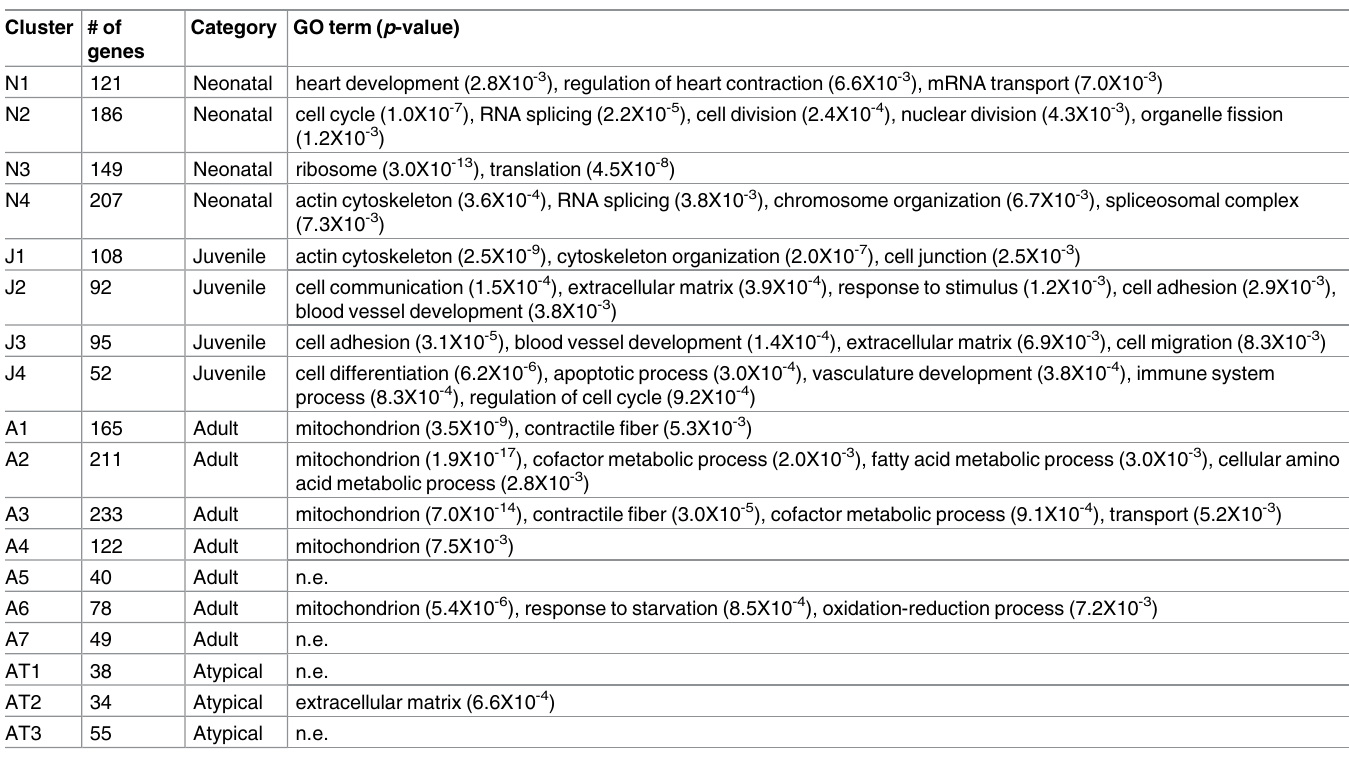
Table 1. Characteristic GO terms enriched in the SOM